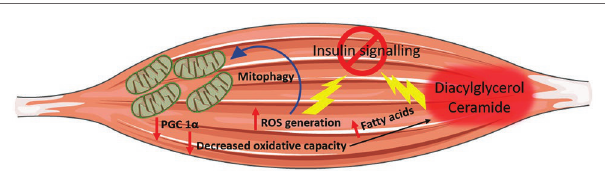
FIGURE 2 | Mitochondrial dysfunction and insulin resistance. Impaired mitochondria oxidative capacity leads to a decrease in metabolic substrate catabolism resulting in increased intramyocellular fatty acids availability, which may be channelled towards lipotoxic lipid species biosynthesis (i.e., ceramide and diacylglycerol) both of which have been associated with insulin resistance. Increased nutrient supplies also induce an increase in mitochondrial reactive oxygen species (ROS) production, which can directly induce insulin resistance and elicit oxidative damage to mitochondrial DNA, protein and lipid promoting the removal of damaged mitochondria by